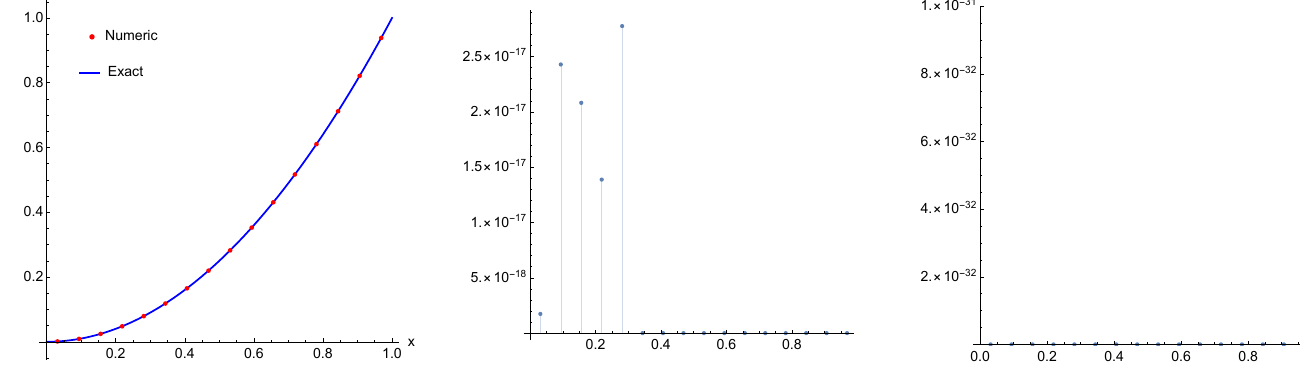
Figure 9. The numerical solution (points) with exact solution ( left ) and the absolute error computed for Example 6 with machine precision ( middle ), and with double precision ( right